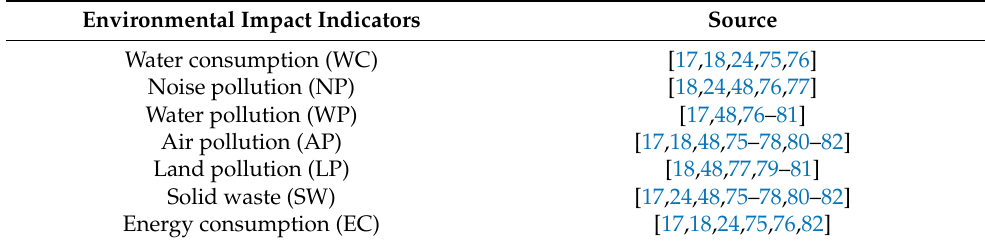
Table 5. Source and abbreviations of environmental impact indicators.